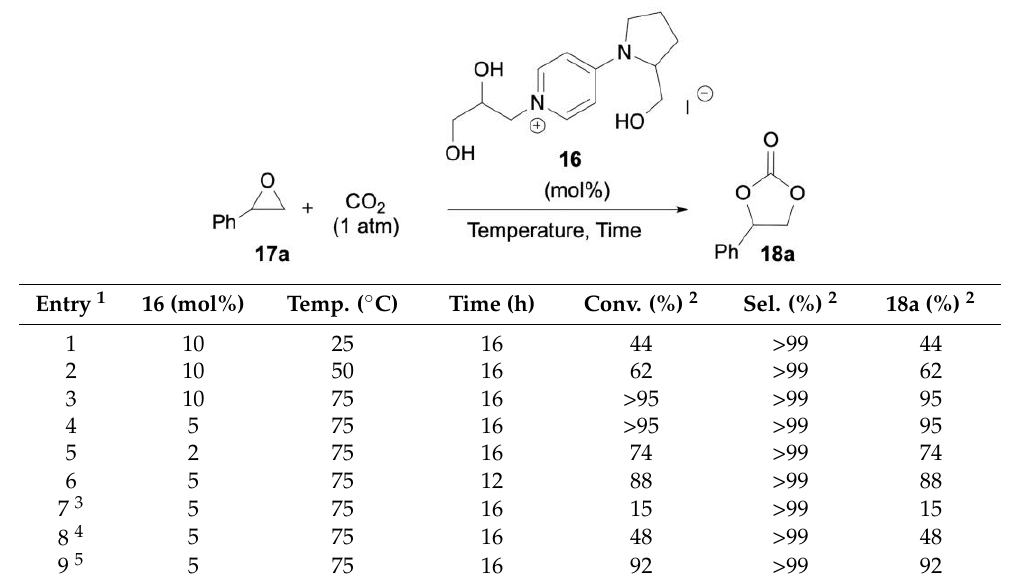
Table 3. Optimization study with catalyst 16 under batch conditions.